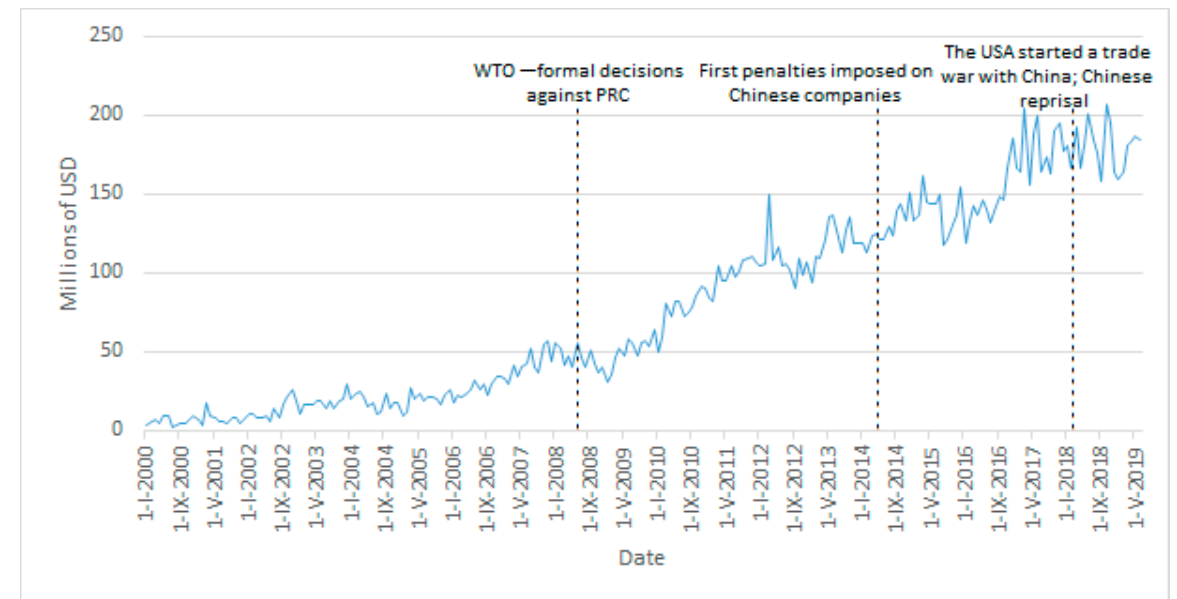
Figure 1. Development of the Czech Republic’s (CR) exports to PRC (People’s Republic of China) between January 2000 and July 2019. Note: The values (throughout the text) are expressed in USD. Source: Authors. Table 1. Basic statistical characteristics of the monitored data